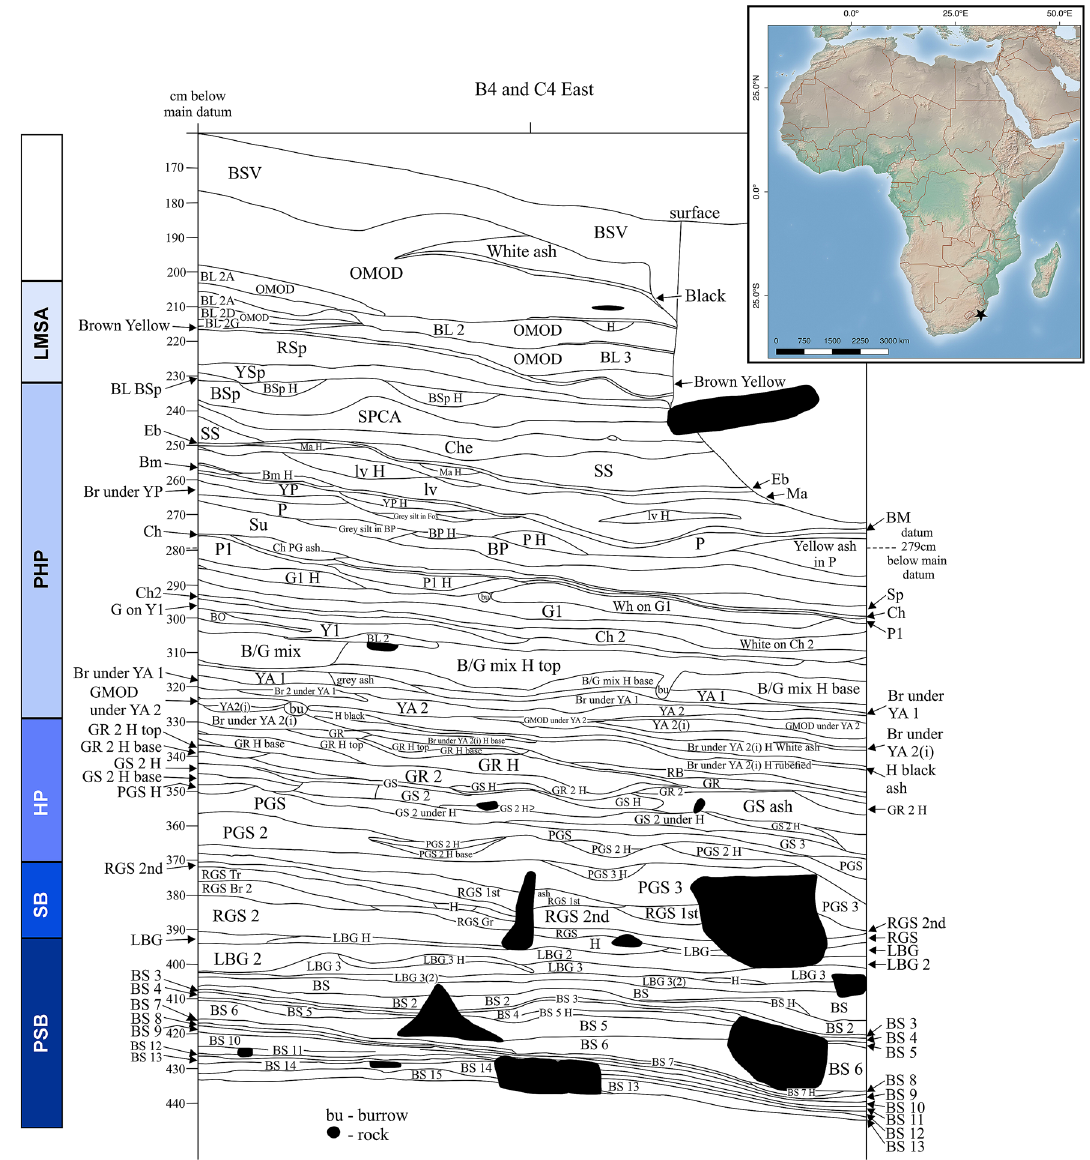
Figure 1. Site location and stratigraphy. Location (star on the map) and stratigraphy of the Sibudu Cave site. The bone tools reported here come from layers attributed to pre-Still Bay (PSB), Still Bay (SB), and Howiesons Poort (HP) technocomplexes (see Table 1). Map insert made by LD using QGIS v. 2.14.3-Essen (Free Software Foundation, Inc., Boston – https:// downl oad. qgis. org/ downl oads/) using free vector and raster from Natural Earth